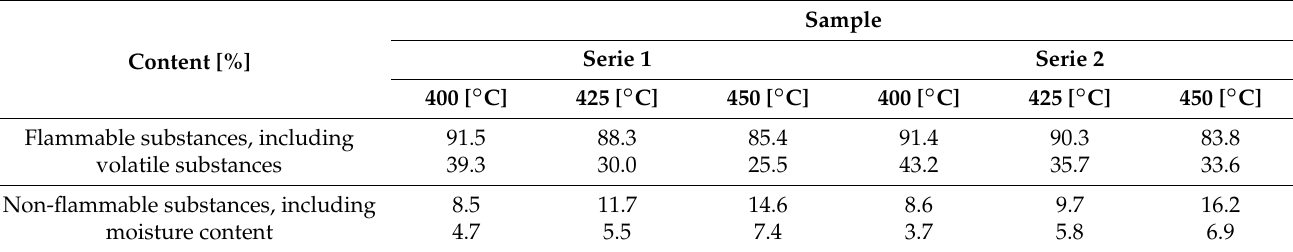
Table 4. Results of the analyses of the char’s fuel-related properties. Series 1—pre-consumer waste. Series 2—post-consumer